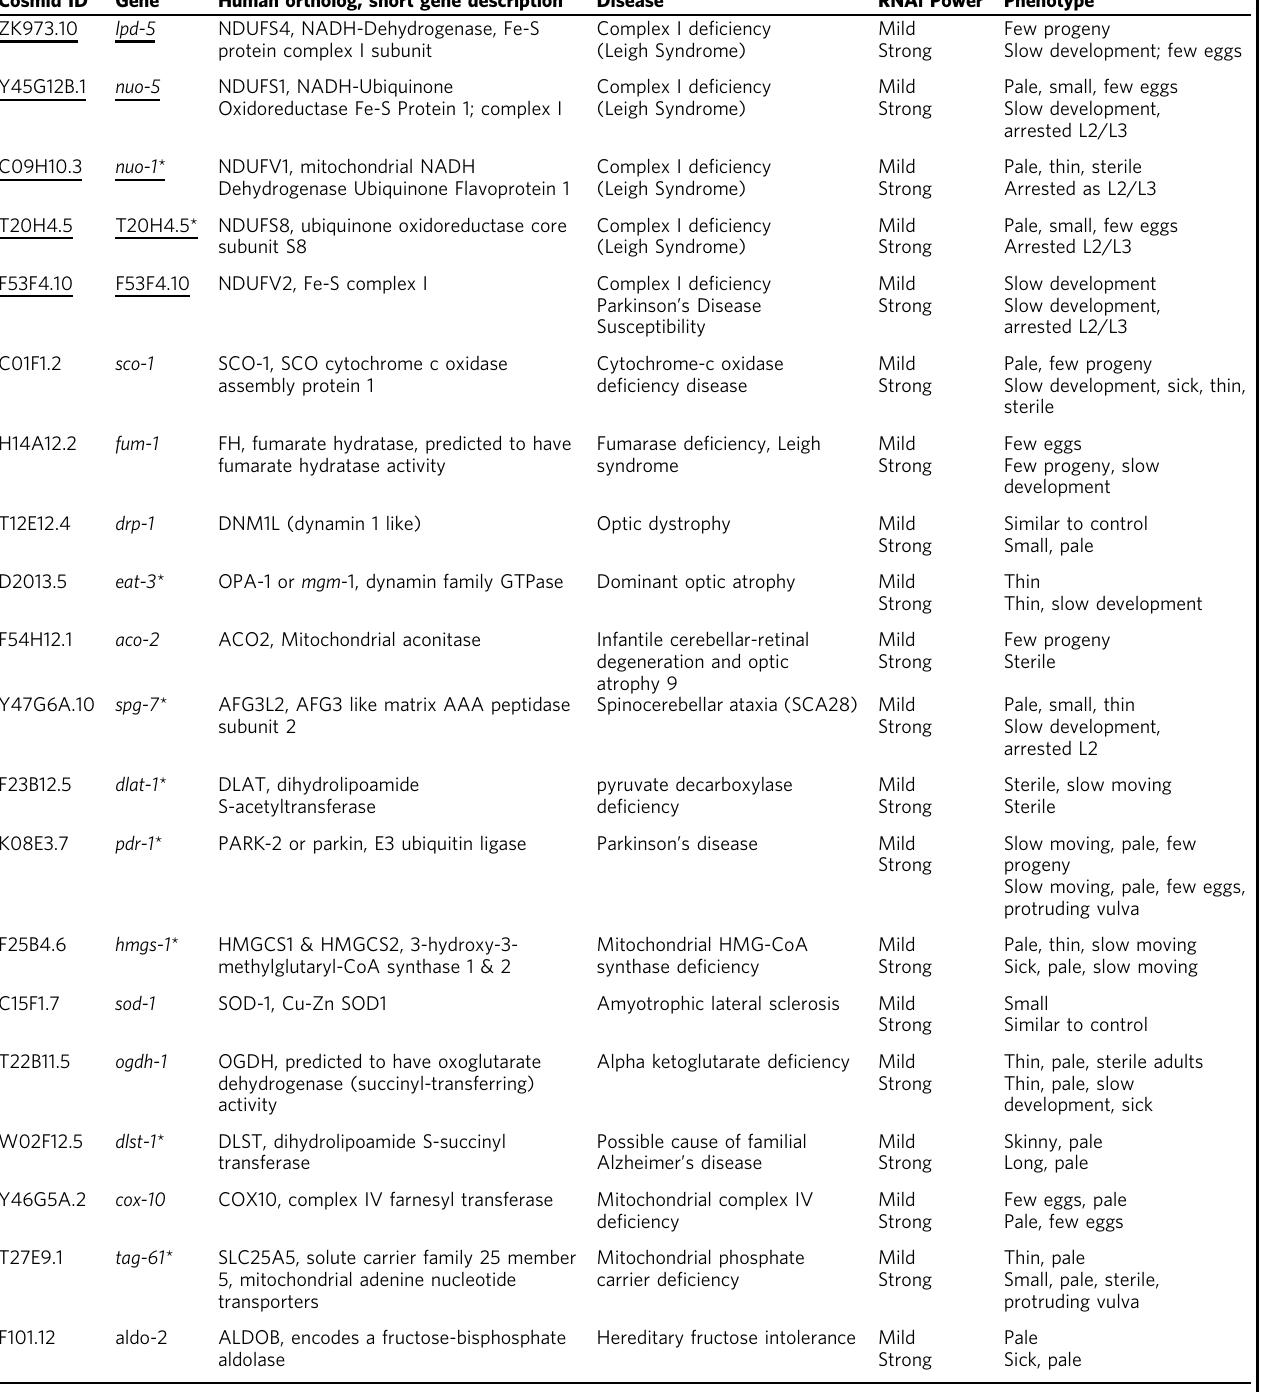
Table 1 List of genes whose different degree of silencing consistently led to the typical Mit phenotypes. Cosmid ID